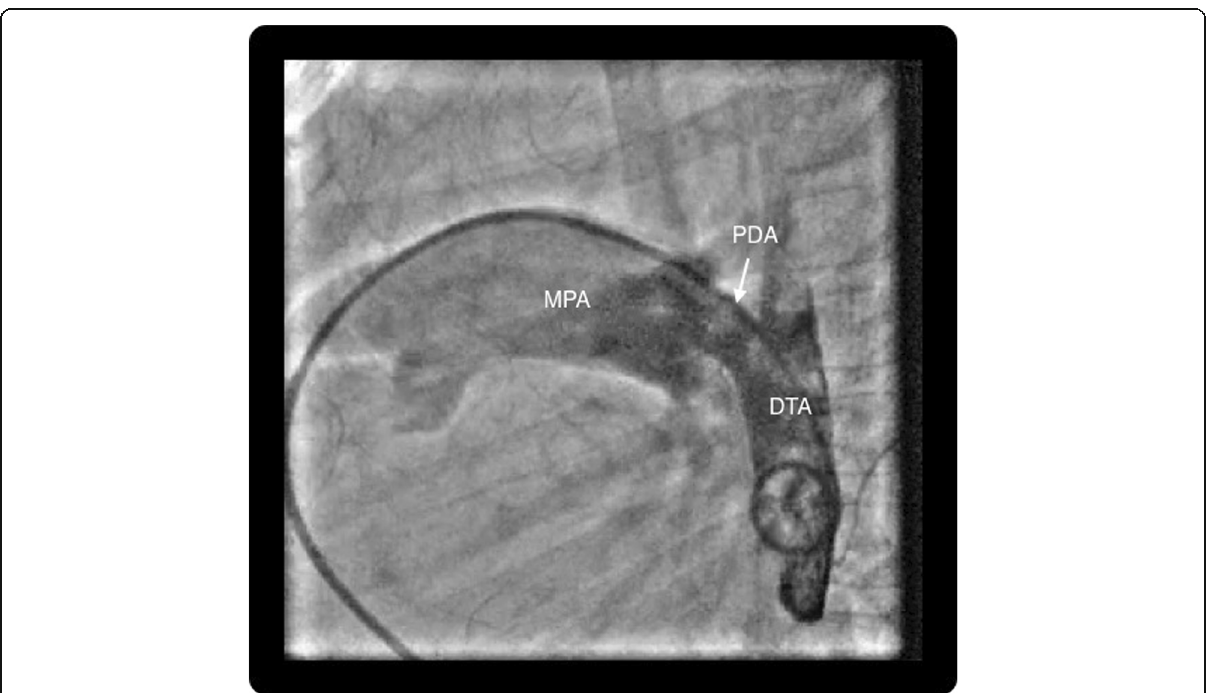
Fig. 1 Contrast injection through 5-Fr pigtail catheter in lateral projection inserted from the pulmonary artery to the descending aorta across patent ductus arteriosus. MPA main pulmonary artery, DTA descending thoracic